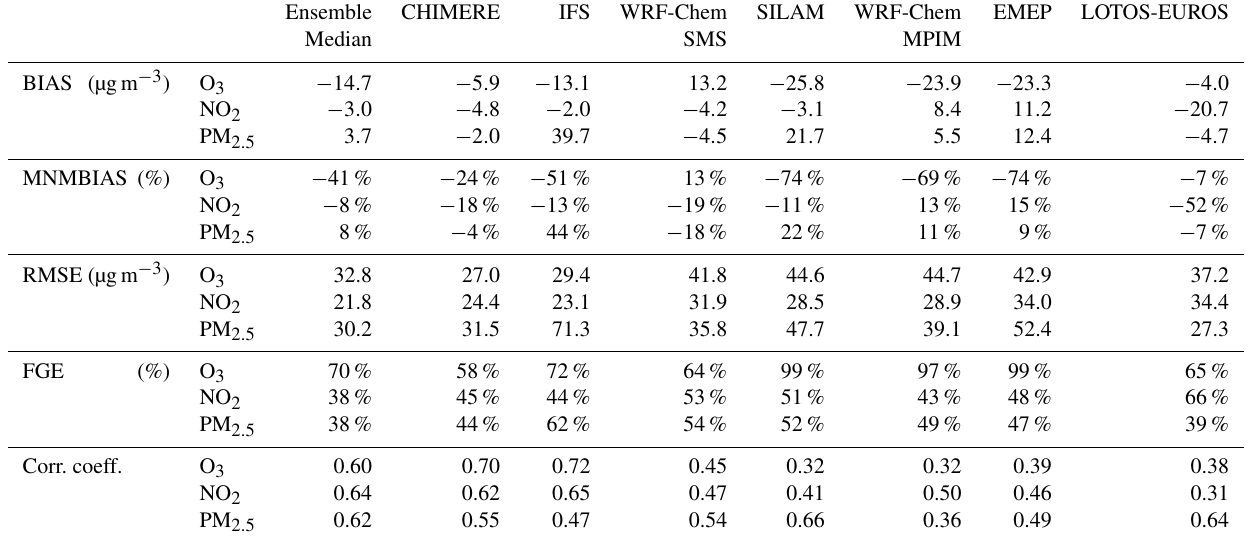
Table 4. For the period 1 to 15 March 2017, statistical measures (mean bias (BIAS), mean normalized bias (MNMBIAS), root mean square error (RMSE), FGE (fractional gross error), and correlation coefficients) calculated for the forecast of O 3 , NO 2 , and PM 2 . 5 concentrations for all models and for the ensemble median at all stations/cities, for which the MarcoPolo–Panda Forecast is available. The correlation is based on 1-hourly data.